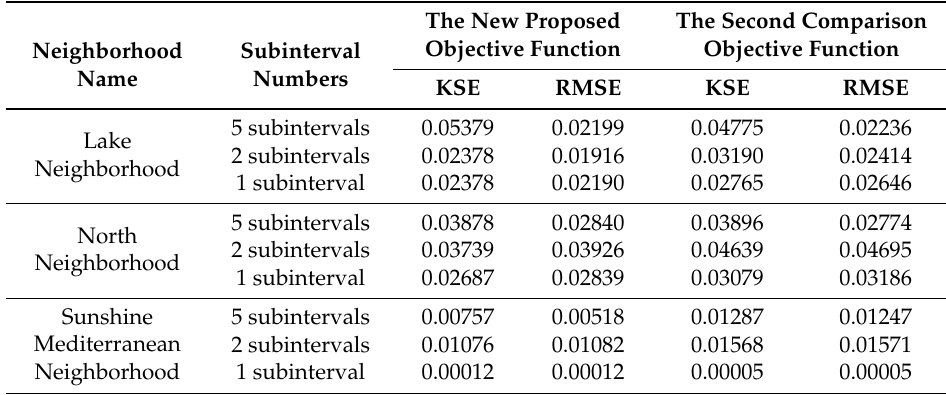
Table 4. Error values under different subinterval numbers. Kolmogorov-Smirnov test error (KSE); root mean square error